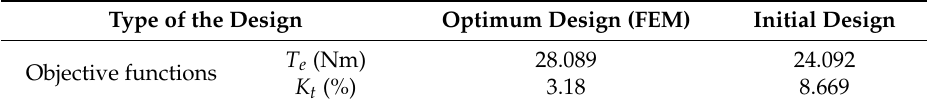
Table 6. Comparison of the objective functions between the optimum design and initial design.